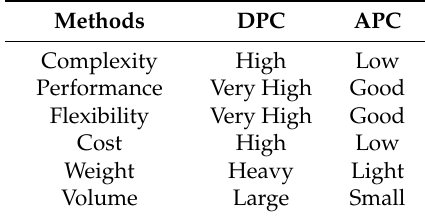
Table 2. Comparisons between DPC and APC.